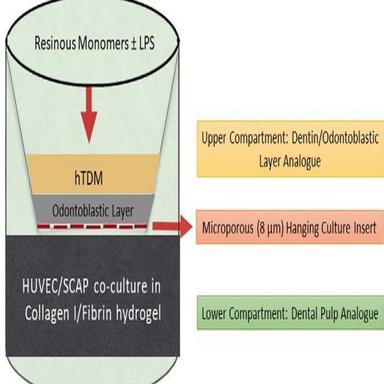
Schematic representation of the assembled DentCytoTool, modelling a dentin/pulp organotypic analogue comprised of two compartments: 1. the upper compartment representing the dentin component with a DPSC-derived layer of odontoblast-like cells expanded on a microporous membrane (8 m) of a cell culture insert (Millicell®, Merck Millipore), covered by a disc-shaped human treated dentin matrix (hTDM), 2. the lower compartment, representing a pulp analogue, incorporating HUVEC/SCAP co-cultures into a collagen I